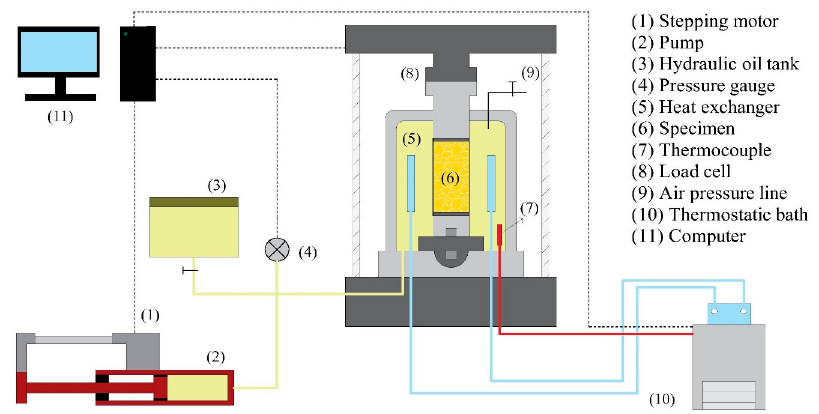
Figure 1. Schematic illustration of experimental apparatus.